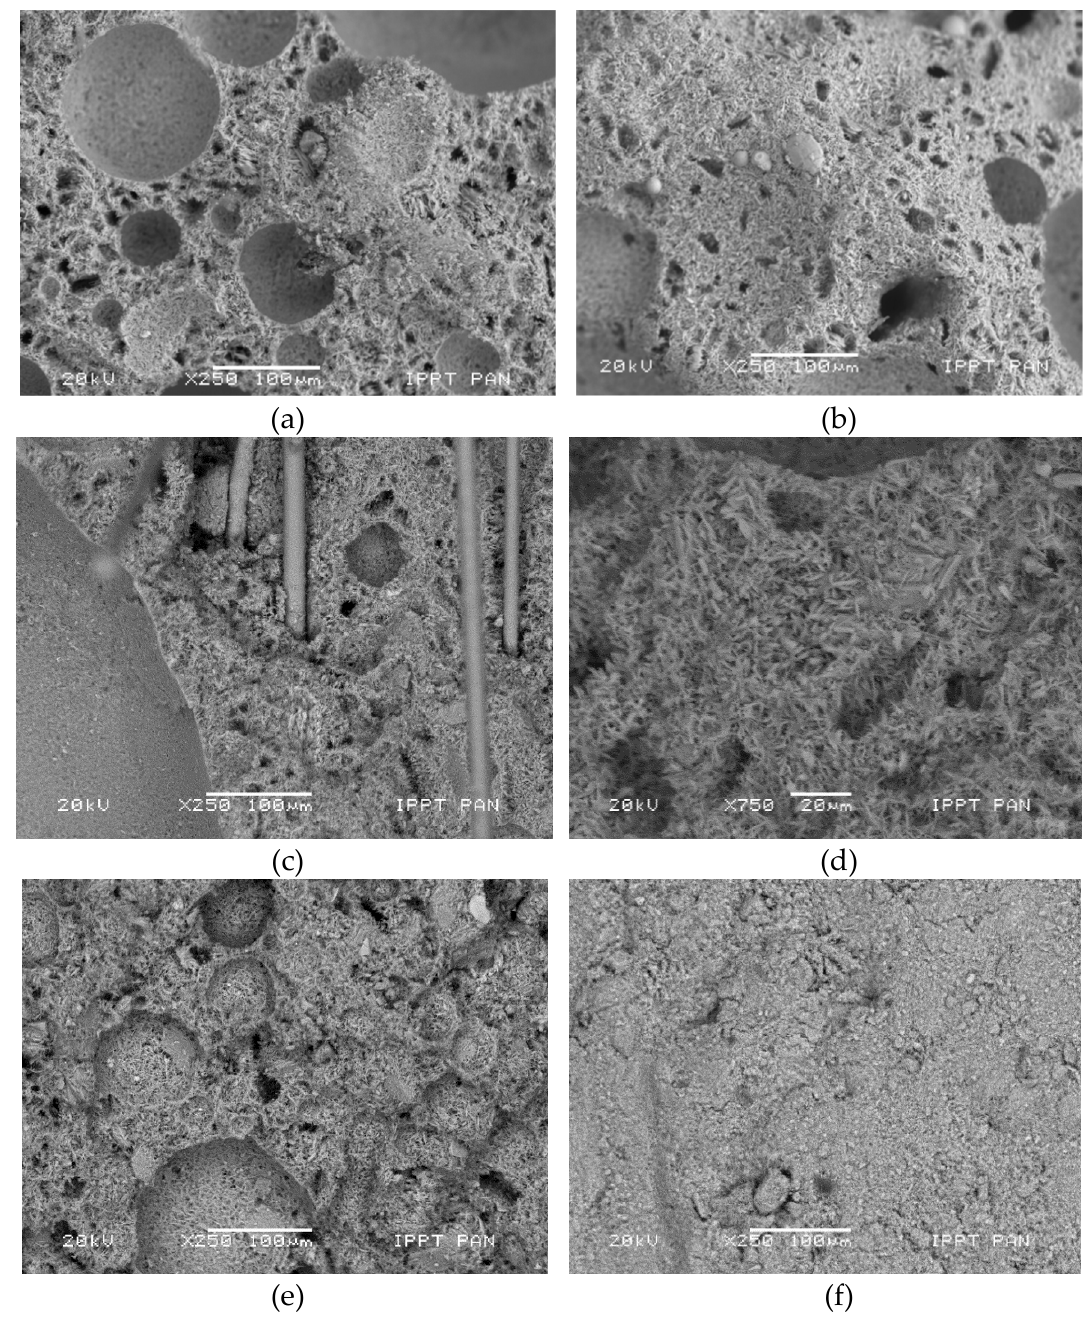
Figure 6. Microstructure of investigated specimens: ( a ) type A, ( b ) type B, ( c ) and ( d ) type G—low and high magnifications of the glass-fiber-reinforcement region—( e ) type I, ( f ) type K. Table 3. Chemical composition of the plasterboards made of materials A and G.